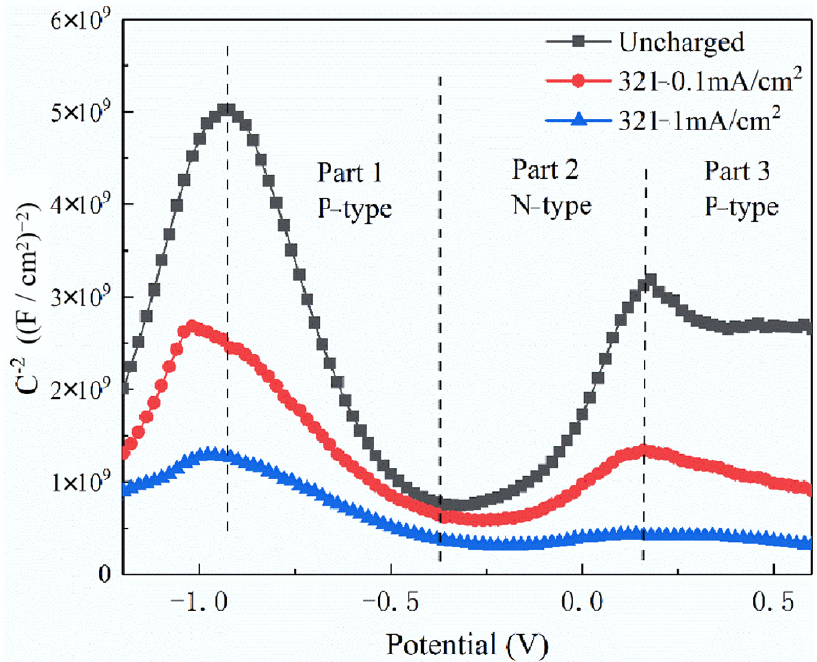
Figure 9. The M-S curve of 321 stainless steel under different hydrogen charging current densities in 1 wt% NH 4 Cl aqueous solution. 1 wt% NH 4 Cl aqueous